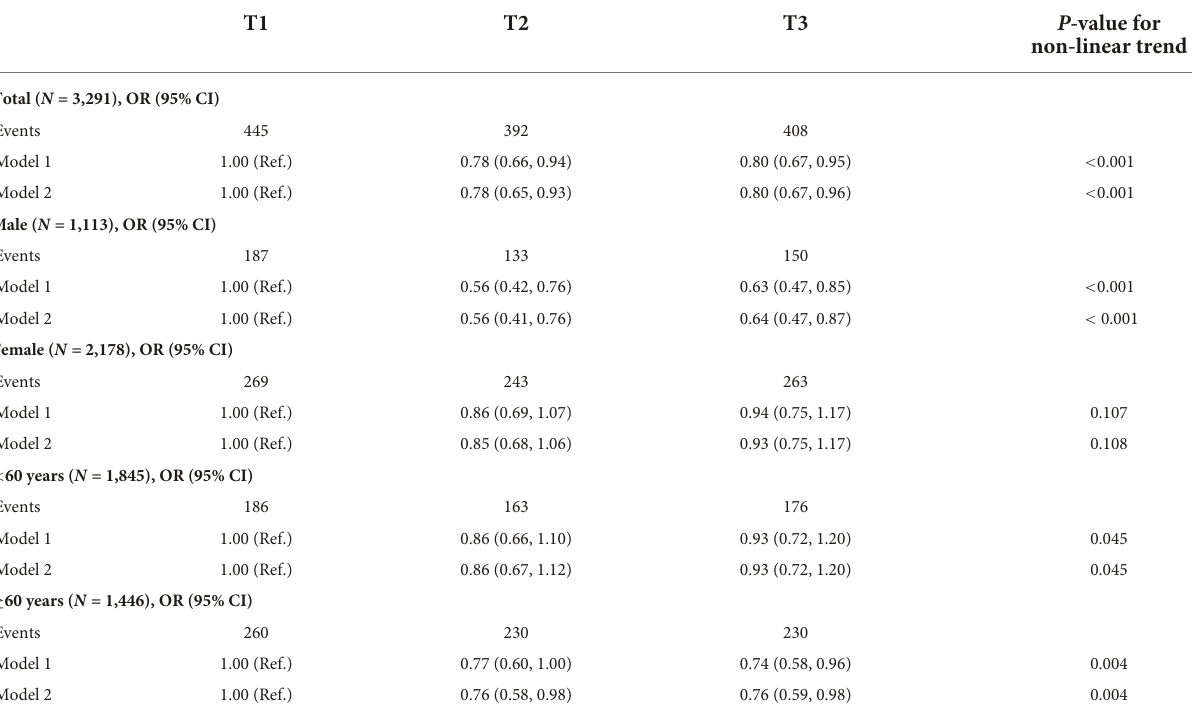
TABLE 2 Association between serum SPD levels and prevalent MCI. a